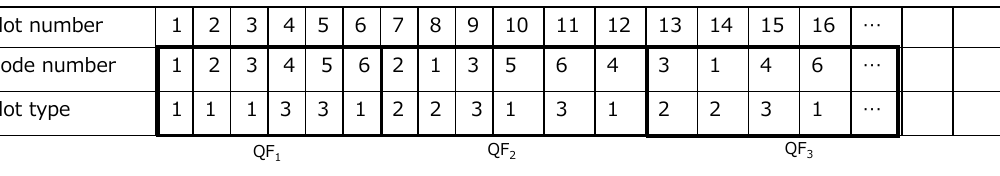
Figure 7. An example of chromosome encoding.